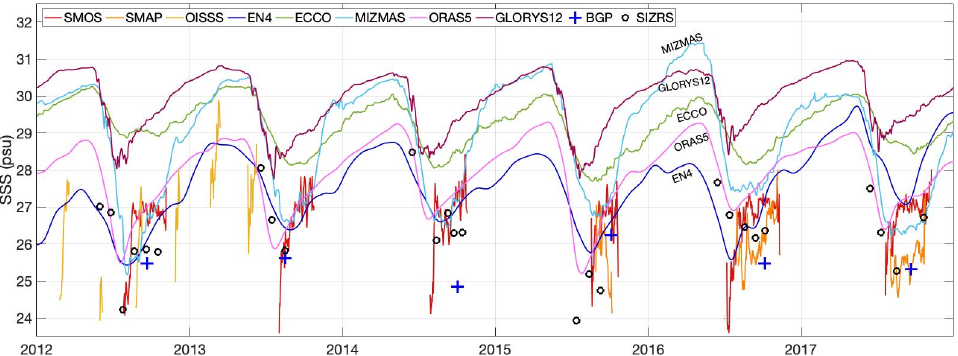
Figure 4. Averaged sea surface salinity (SSS) along a 150°W transect between 70.5°N–80.5°N as seen